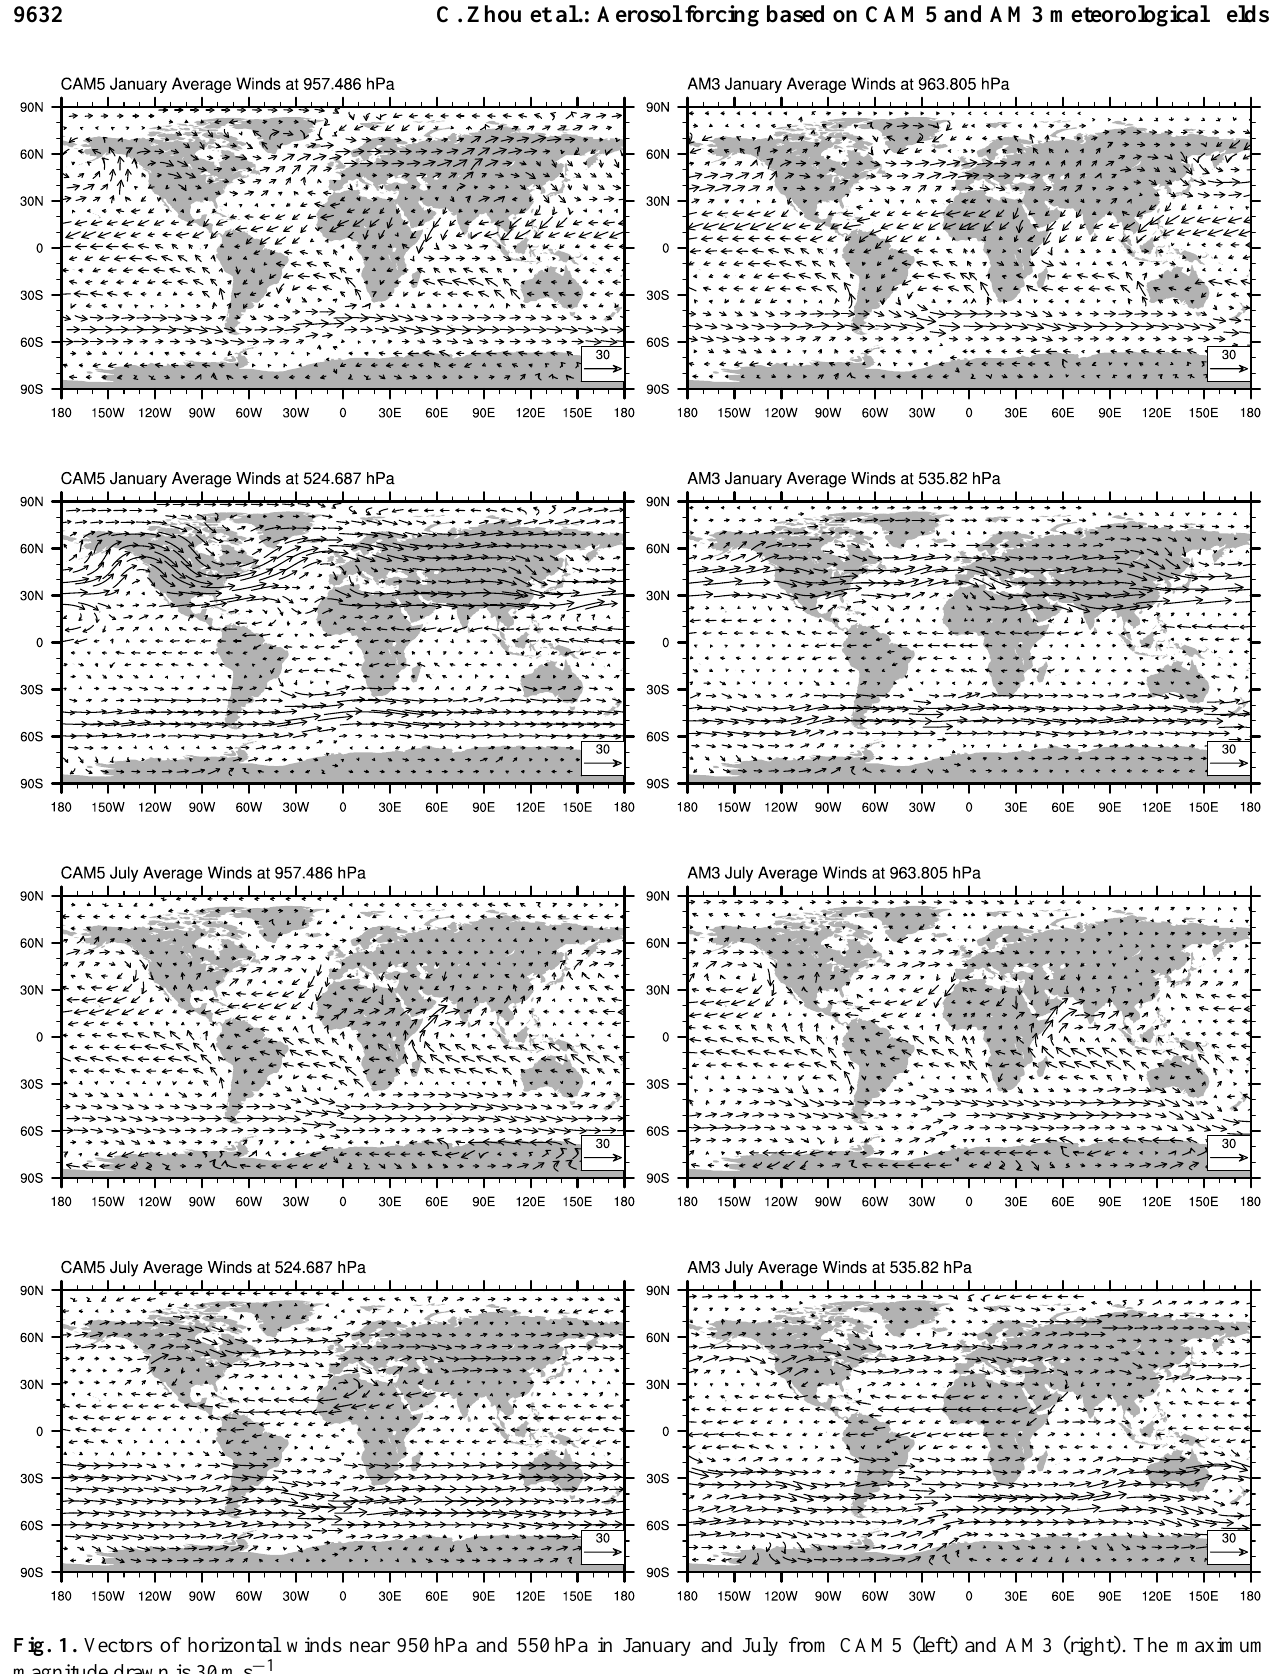
Fig. 1. Vectors of horizontal winds near 950hPa and 550hPa in January and July from CAM5 (left) and AM3 (right). The maximum magnitude drawn is 30ms − 1